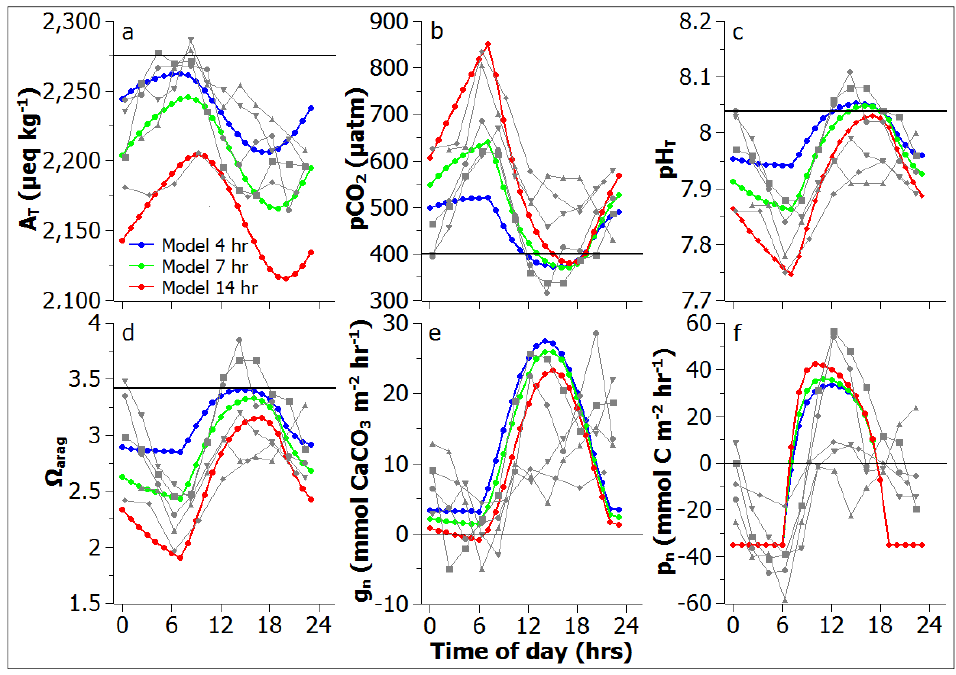
Figure 1. ( a – d ) Plots of modeled changes in seawater chemistry; ( e ) net ecosystem calcification; and ( f ) net ecosystem production in comparison to measurements made on the reef flat by Shamberger et al. [10], shown in grey. pH is reported here on the Total hydrogen ion scale (pH ). Model output is for the calcification and dissolution + T photosynthesis and respiration feedback scenario (GD + PR) under present-day seawater conditions (results from other modeled feedback scenarios under present-day conditions are very similar). Thick, black line (a – d) shows offshore, seawater chemistry conditions. Thin black line ( e , f ) shows zero on the